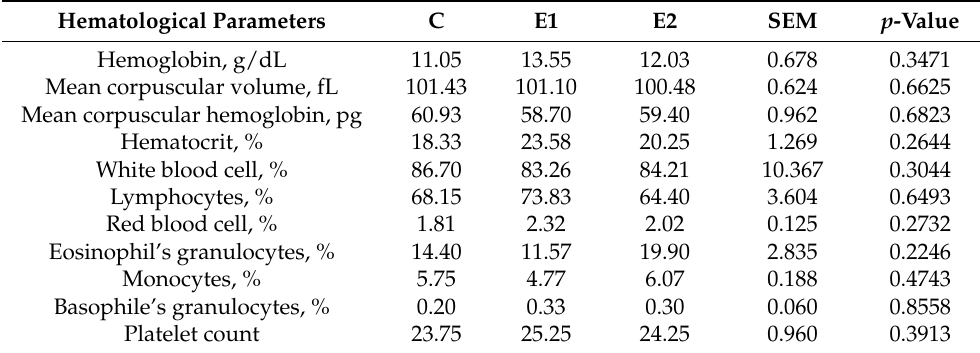
the E2 diet compared with the C and E1 diets. Egg weight was significantly impacted among the groups, as well as the egg weight classification. Table 4. Hematological parameters of laying hens fed diets supplemented with watermelon rind and sea buckthorn meal.